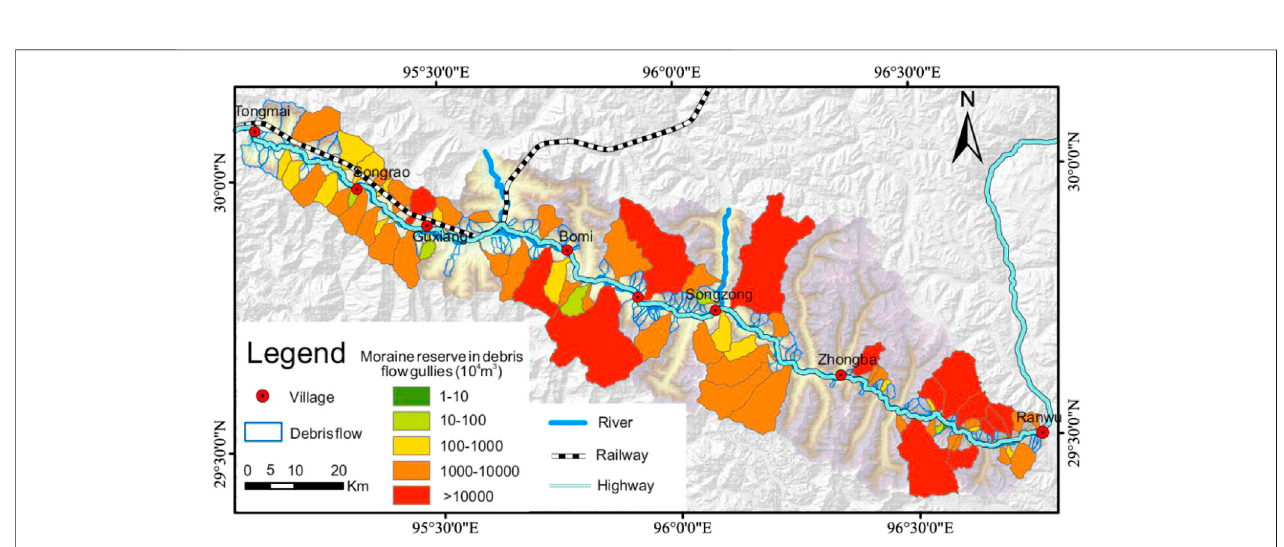
FIGURE 13 | The moraine reserve in glacial debris fl ow gullies in Parlung Tsang basin.